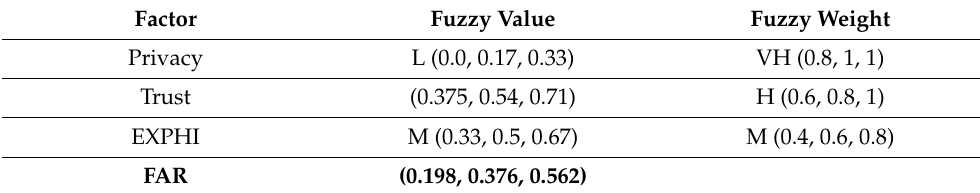
Table 6. Linguistic values for calculation of